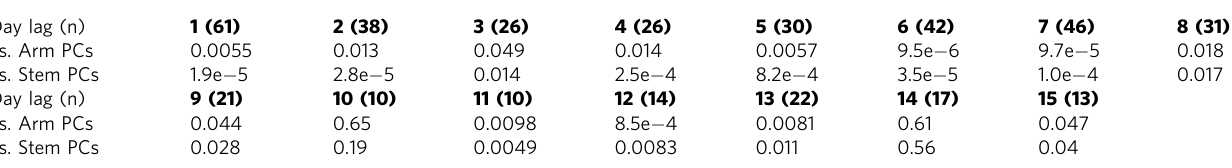
Table 4 One-sided signed-rank signi fi cance values for mean spatial correlation values of splitter vs. arm PCs or splitters vs. stem PCs ( n = session